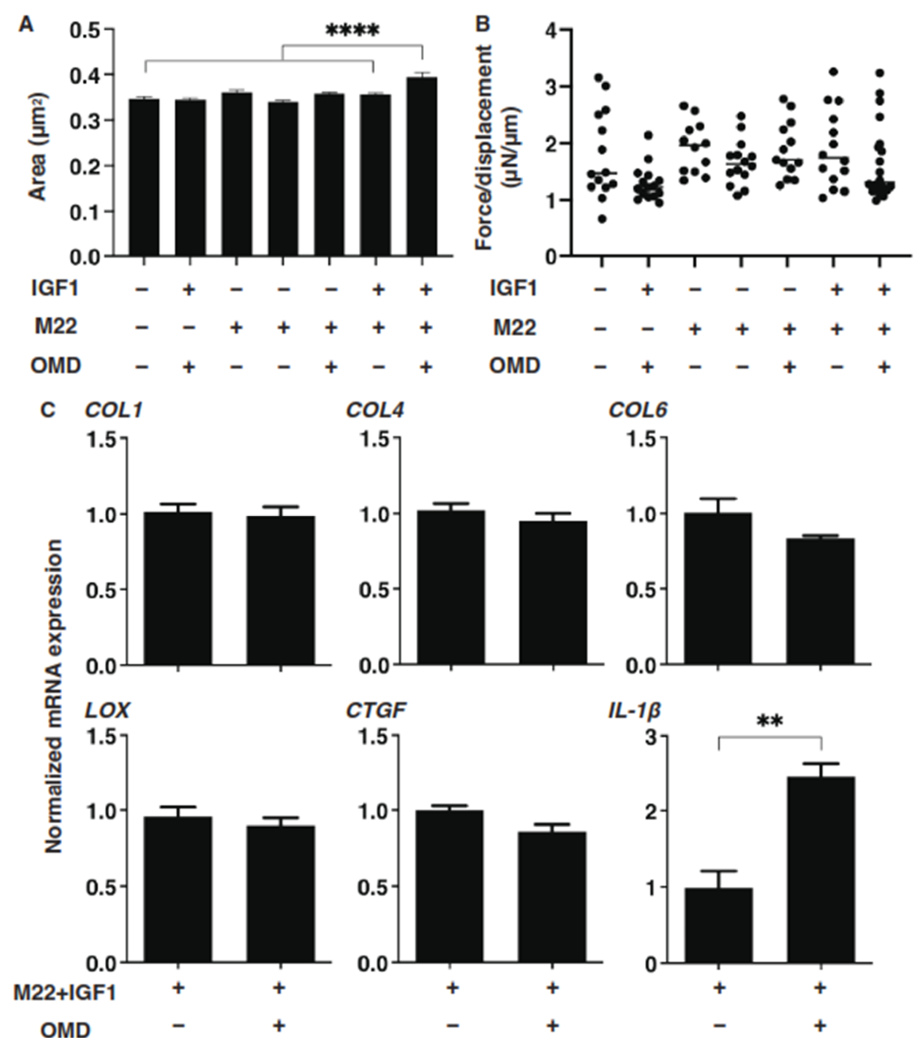
Figure 5. Effects of IGF-1, M22 and/or omidenepag (OMD) on the physical properties, size and stiffness of the n-HOFs 3D spheroids. At Day 6, n-HOFs 3D spheroids were treated with 100 ng/mL IGF-1,10 ng/mL M22 and/or 100 nM omidenepag (OMD), and their mean sizes and stiffness (μN/μm force/displacement) were plotted in panels ( A ) and ( B ), respectively. In panel ( C ), the 10 ng/mL M22/100 ng/mL IGF-1 treated HOFs 3D sphenoids without or with 100 nM omidenepag (OMD) were subjected to a qPCR analysis to estimate the mRNA expression of selected ECMs ( COL ; collagen1, 4 and 6 ), ECM- regulatory genes ( LOX : lysil oxidase, and CTGF : Connective Tissue Growth Factor), and inflammatory cytokines ( IL1β : interleukin-1β), which were differently regulated between GHOFs and n-HOFs upon the administration of 100 nM OMD (Table 2). All experiments were performed in duplicate using fresh preparations, each of which consisted of 16 spheroids. Data are presented as the arithmetic mean ± standard error of the mean (SEM). ** p < 0.01, **** p < 0.001 (ANOVA followed by a Tukey’s multiple comparison test). 3.4. Comparison of Several mRNA Expressions of ECM, ECM Modulators, Inflammatory Cytokines, and ER Stress-Related Genes among n-HOFs, GHOFs and M22/IGF-1-Stimulated n- HOFs 3D Spheroids.